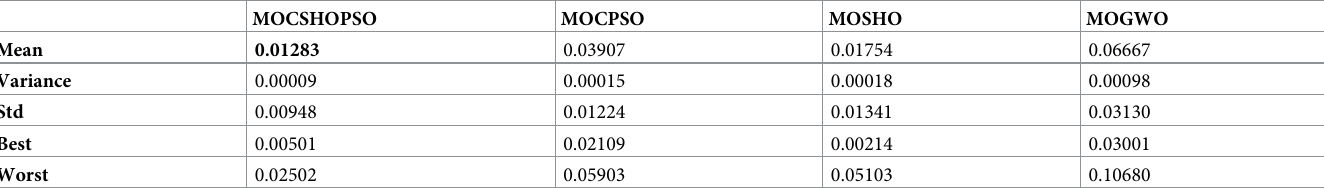
Table 3. Comparative analysis of different algorithms based on the